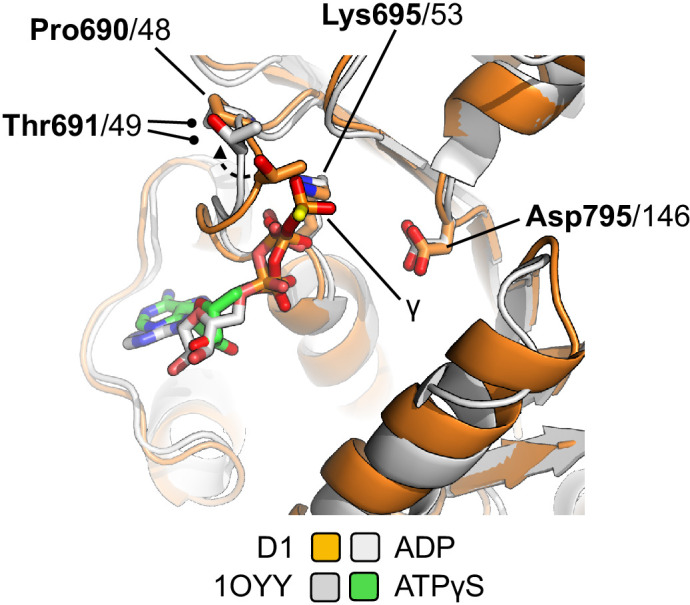
The active site of the liganded complex is compatible with binding of ATP, as judged by superposition of PDB entry 1OYY (E. coli RecQ in complex with ATP-γS Bernstein et al., 2003).Only a small movement of Thr691 would be necessary to accommodate the gamma phosphate group (as indicated by the dotted line / arrowhead). Only the D1 domain of each protein is shown in order to improve clarity.